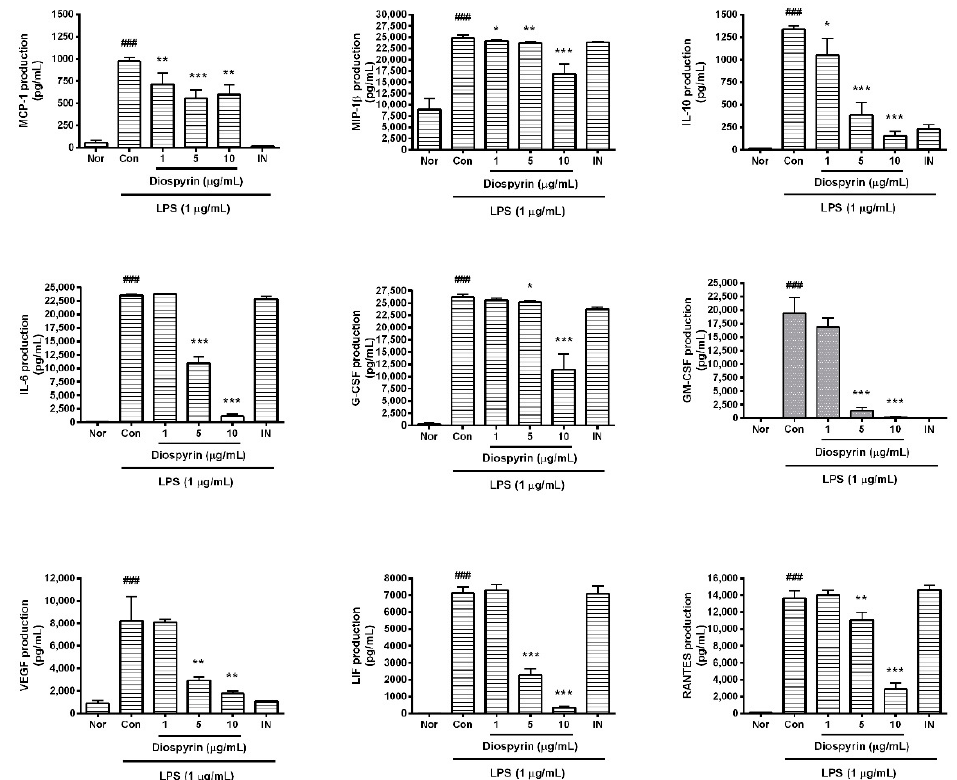
Figure 3. E ff ect of diospyrin on production of monocyte chemotactic protein (MCP)-1, macrophage inflammatory protein (MIP)-1 β , granulocyte colony-stimulating factor (G-CSF), granulocyte macrophage colony-stimulating factor (GM-CSF), vascular endothelial growth factor (VEGF), RANTES / CCL5, leukemia inhibitory factor (LIF; IL-6 class cytokine), interleukin (IL)-6, and IL-10 in LPS-stimulated RAW 264.7. Data are of mean ± SD and pooled from more than three independent experiments. Nor, normal group (media only); Con, control group (LPS alone); IN, indomethacin (0.5 µ M). ### p < 0.001 vs. Nor; * p < 0.05 vs. Con; ** p < 0.01 vs. Con; *** p < 0.001 vs. Con.